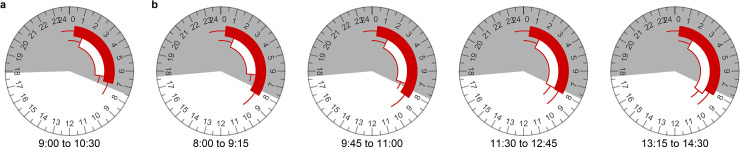
Sleep pattern among students that reported sleeping before the test from a) School of Science (survey #1); b) four test shifts in School of Psychology (survey #2).